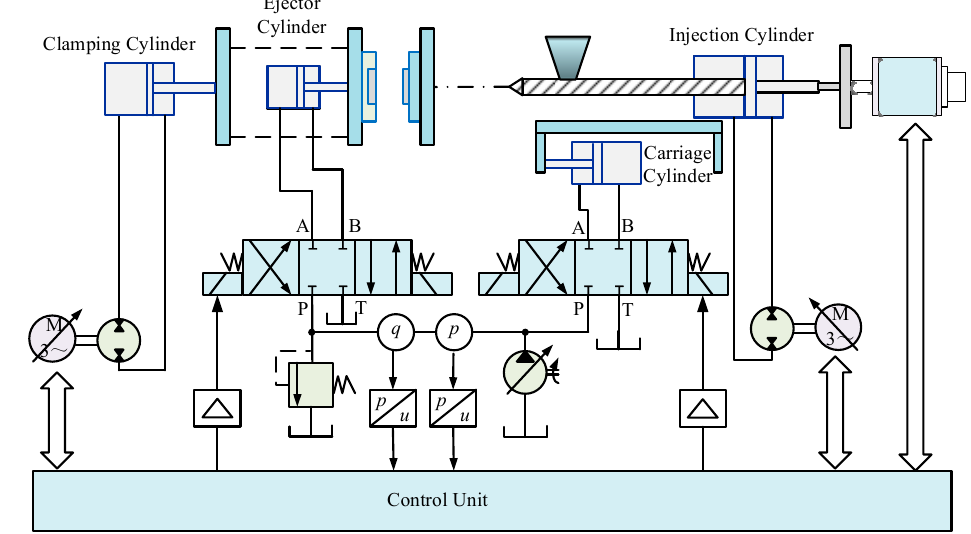
Figure 7. The hybrid control scheme of an electric-hydraulic IMM.